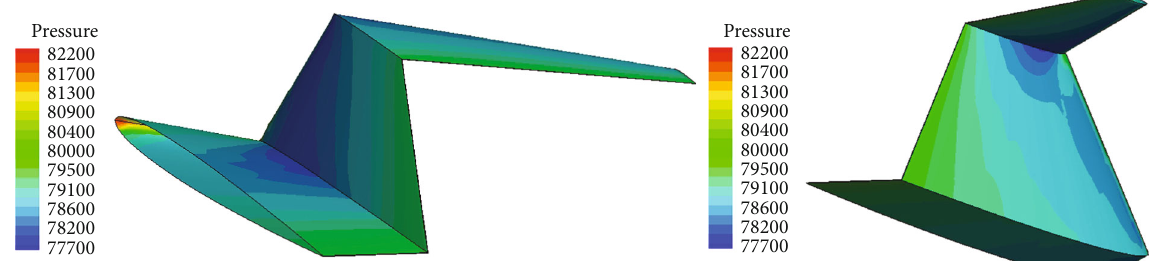
Figure 15: Low-pressure areas caused by airfoil thickness ð θ = 90 ∘ Þ .